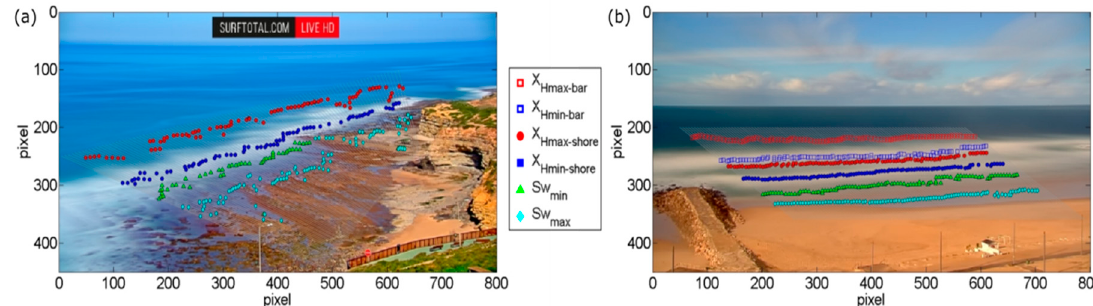
Figure 10. Along-shore identification of wave transformation domain boundaries. ( a ) Example of spatial distribution of morphodynamic zone boundaries plotted on Timex image at Ribeira d’Ilhas; ( b ) example spatial distribution of morphodynamic zone boundaries plotted on Timex image at Tarquinio-Paraiso. Legend is common to both